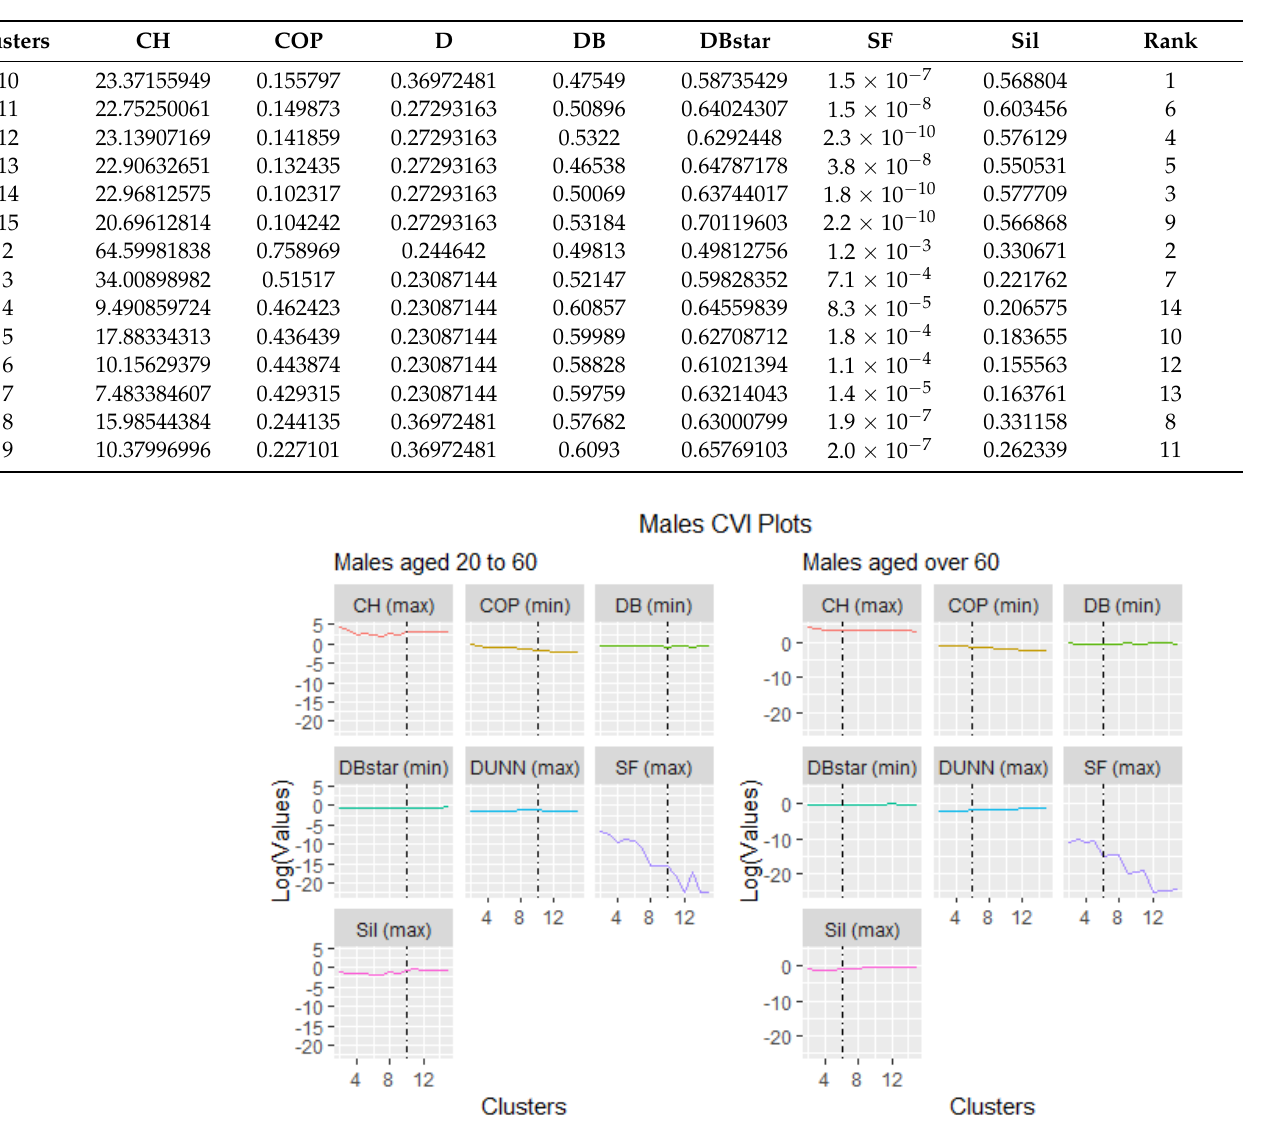
Table 9. CVI results for males aged 20 to 60.